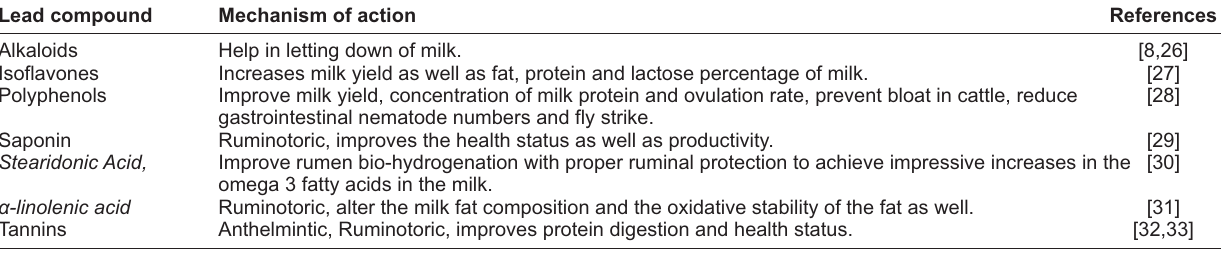
Table-3: Commercial drugs available in market used as galactogogues. Brand